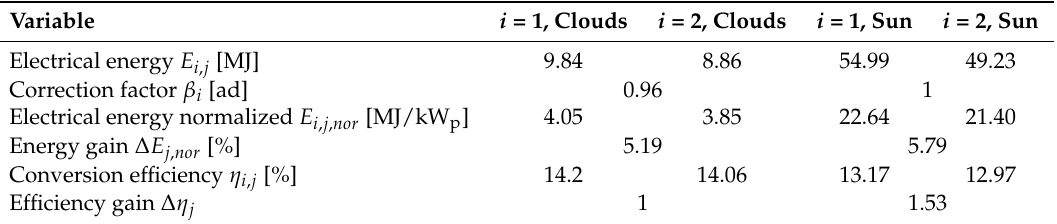
Table 2. PV arrays’ energy production and conversion efficiency during a sunny and a cloudy day of the first campaign. Variable i = 1, Clouds i = 2, Clouds i = 1,